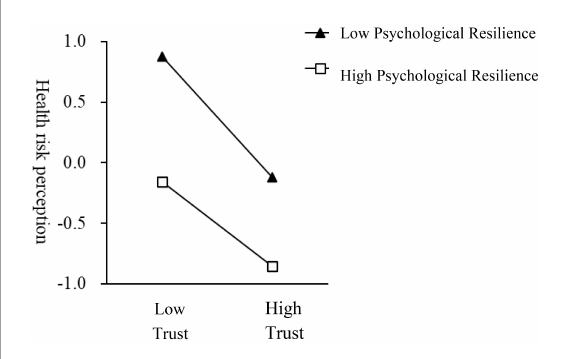
FIGURE2 Moderating effect of psychological resilience on the relationship between trust and travel